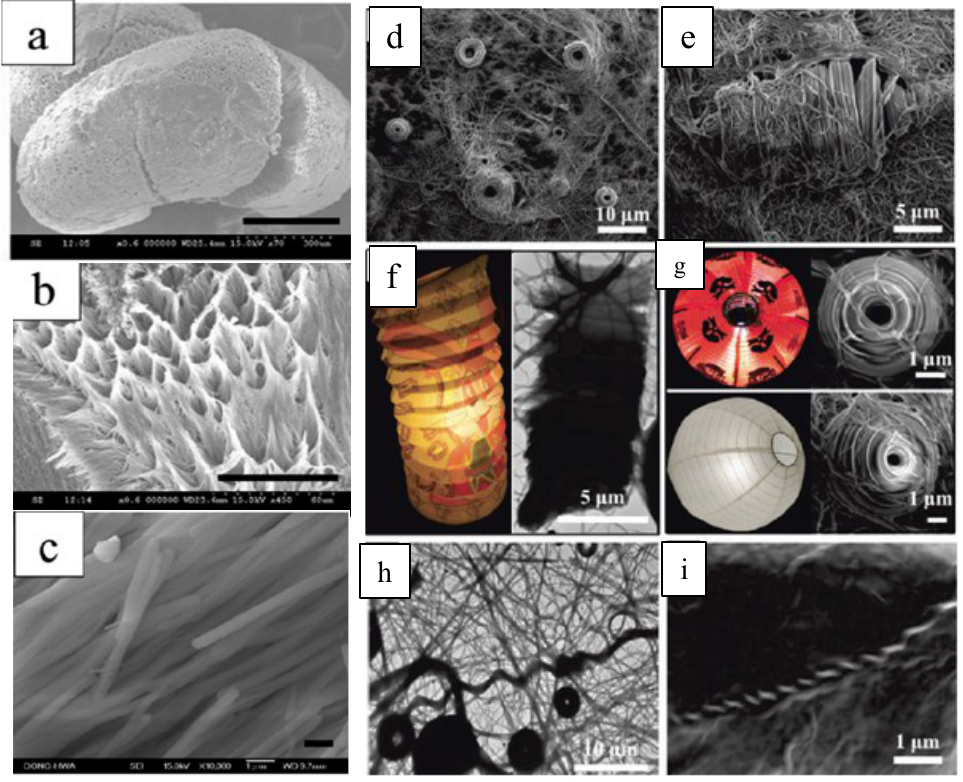
Figure 3. Representative scanning electron microscopic (SEM) micrographs of solid [Au(C1 2 ,amide-imy) 2 ][Br] from hot MeOH. ( a ) porous, donut-shaped feature as seen under low magnification; ( b ) porous surface for a magnified section and ( c ) fibrous microstructure under high magnification. (bar = 300, 60, and 1 μm, respectively), ( left ); ( d , e ) are representative SEM micrographs of the xerogel of [Au(C1 2 ,amide-imy) 2 ][NO 3 ] from dimethyl sulfoxide (DMSO); ( f ) A transmission electron microscopic (TEM) image of the xerogel showing a lantern-shaped morphology, picture of the lantern.; ( g ) SEM images of lantern-shaped fibrous bundles of xerogel; ( h ) the TEM image of fibers, lantern-shaped fibrous bundles, and a helical like belt; ( i ) SEM image of the xerogel from [Au(C 18 ,amide-imy) 2 ][NO 3 ] showing a helical belt ( right ). Adapted with permission from ref. [36]. Copyright 2012 American Chemical